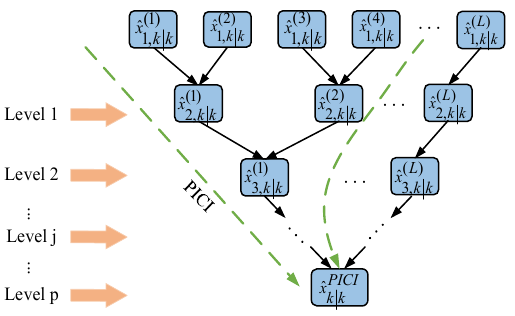
Figure 3. PICI fusion algorithm.